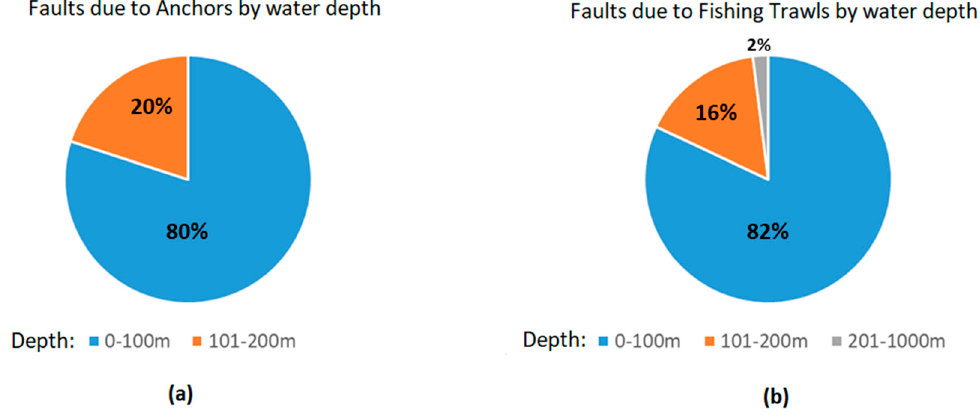
Figure 4. Underwater cable threats by water depth from 2016–2018: ( a ) anchor faults depth distribution, ( b ) fishing trawl faults depth distribution [17].